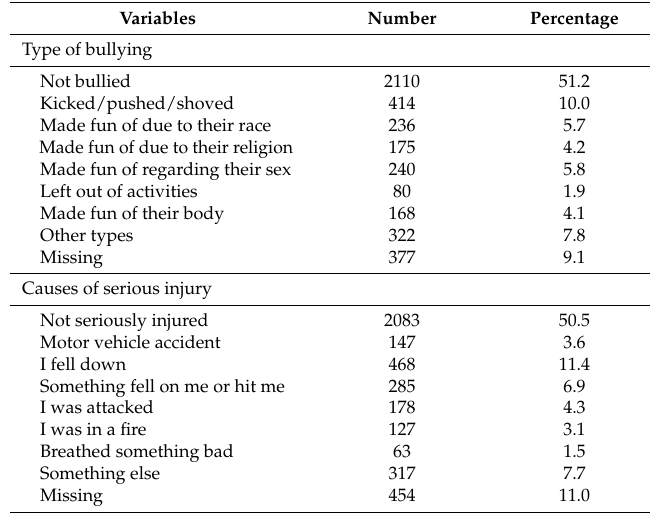
Table 3. Type of bullying victimization and causes of serious